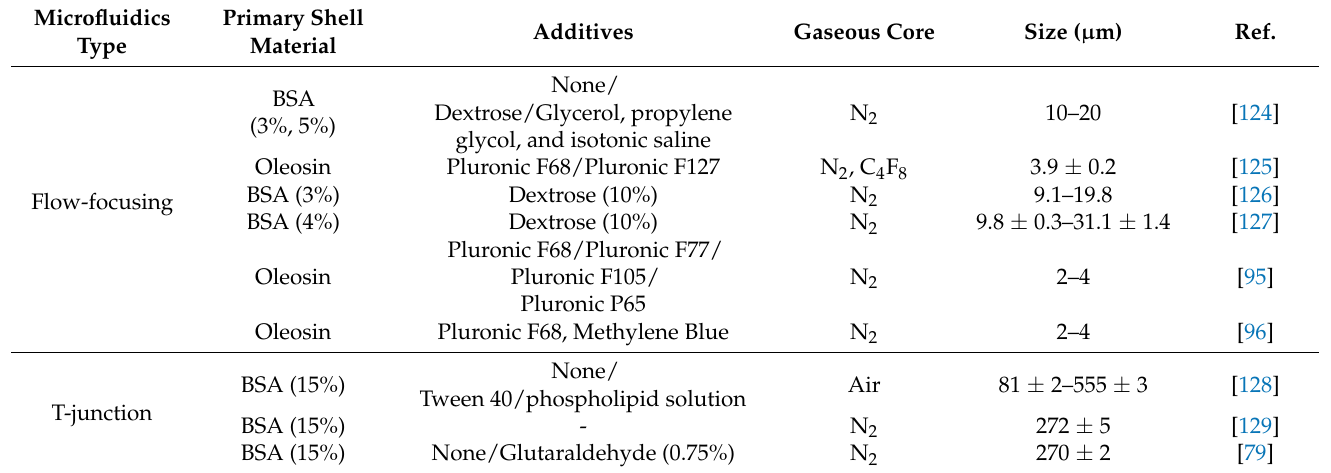
Table 1. Fabrication of MBs with protein shell by microfluidics. All examples within each type of microfluidic device are provided in chronological